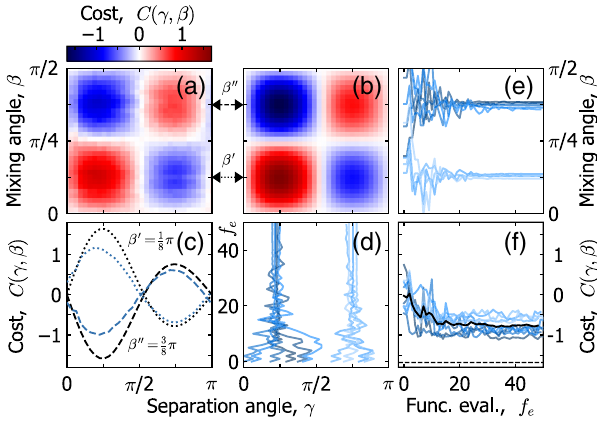
FIG. 13. Cost function evaluated for p = 1 on the seven-qubit problem instance using C Z φ gates. (a) Cost-function landscape as a function of variational parameters. (b) Cost-function land- scape obtained from noise-free simulations. (c) Experimental evaluation (blue) and simulation (black) of the cost function for two horizontal line cuts of (a),(b), with β (cid:9) = π/ 8 (dotted lines) and β (cid:9)(cid:9) = 3 π/ 8 (dashed lines), respectively. (d),(e) Ten convergence traces of the separation angle and the mixing angle, respectively, for end-to-end optimization starting from random parameter initialization. (f) Average energy (solid black line) and individual convergence traces (faded blue lines) of the energy corresponding to parameters shown in (d),(e).